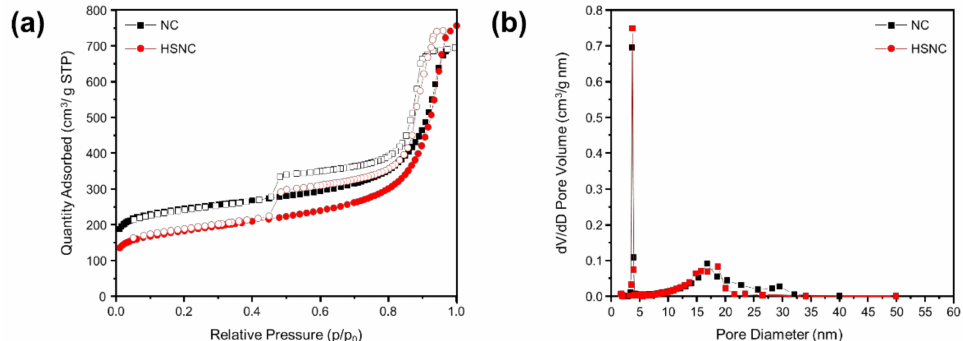
Figure 4. BET analysis showing the ( a ) nitrogen adsorption–desorption isotherms and ( b ) pore-size distribution of the HSNC and NC